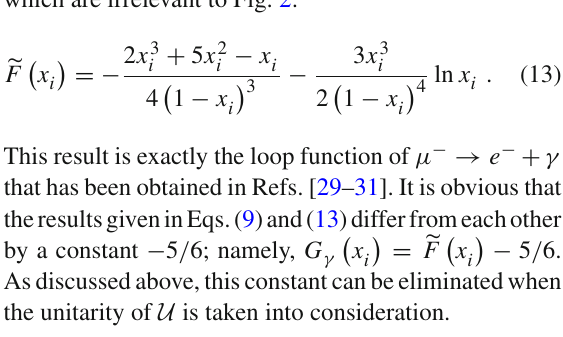
Fig. 3 A numerical illustration of the loop function G γ ≡ λ 2 / M 2 . In the light gray ( x with x i i W (cid:3) 2 . 2 × 10 7 ) regimes, the asymptotic limits G ( x i − 1 / 3 hold respectively up to the accuracy of O ( 10 − 6